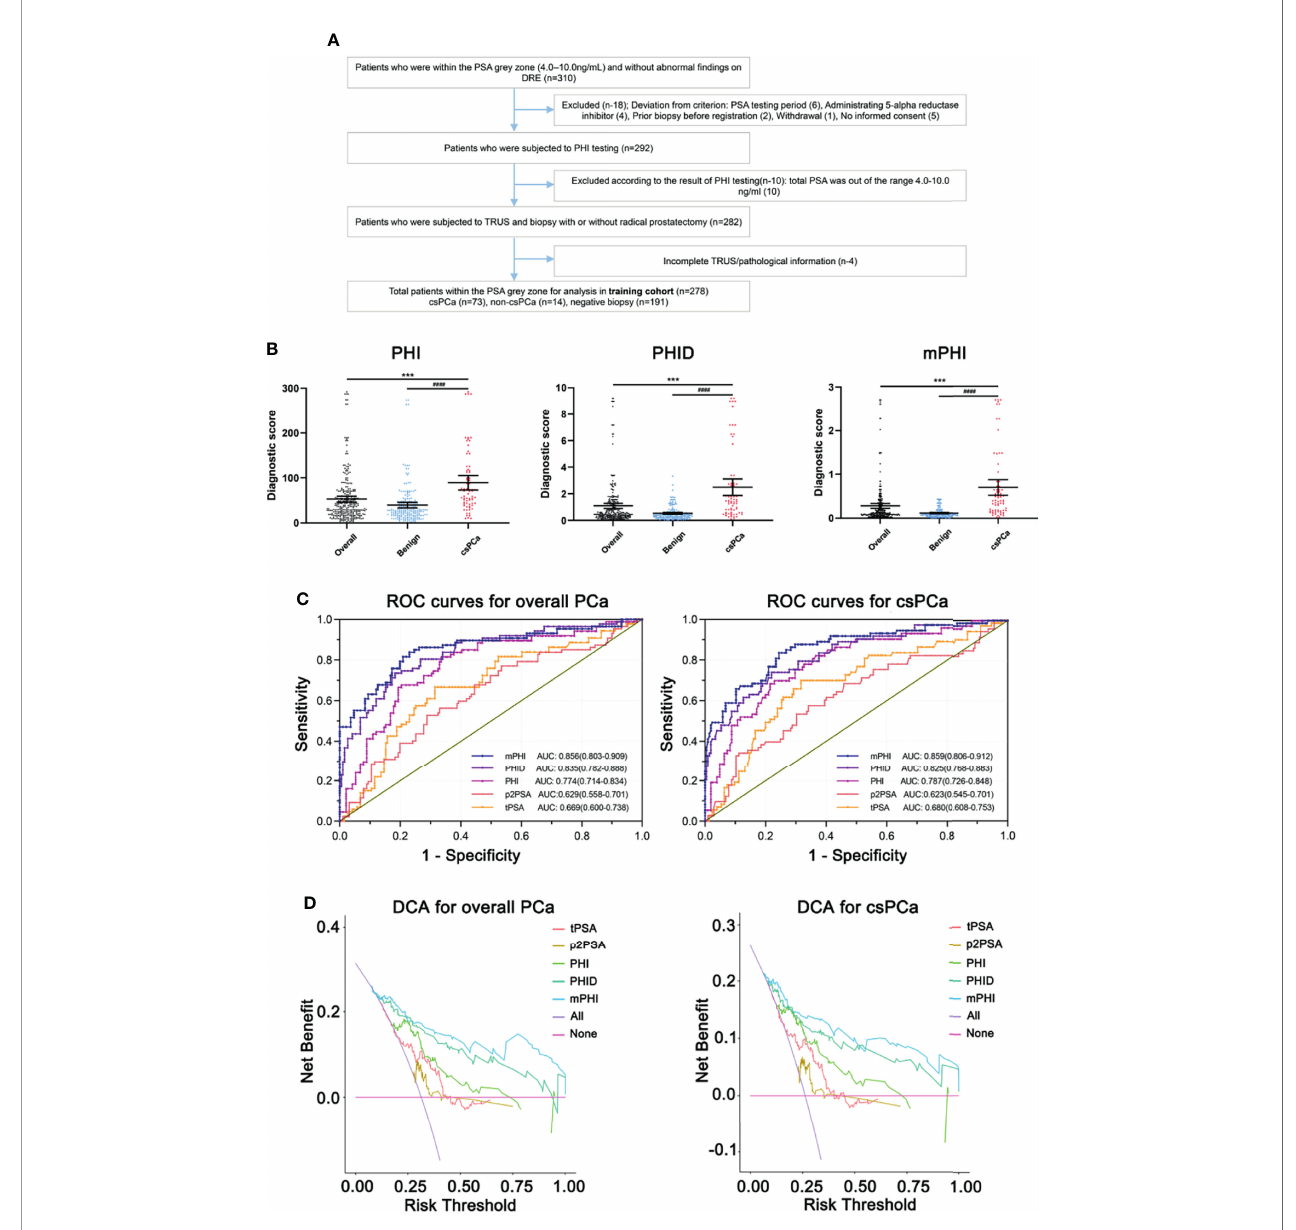
FIGURE 1 | (A) Flow diagram of enrolled participants of the training cohort. (B) Diagnostic scores of PHI, PHID, and mPHI in clinically signi fi cant prostate cancer and benign biopsies identi fi cation. *Overall vs csPCa, # Benign vs csPCa. Data are shown as Mean ± SEM. ***P <0.001, #### P <0.0001. (C) Receiver operating analysis (ROC) curve of the training cohort show the area under the ROC curve for overall PCa (left) and clinically signi fi cant prostate cancer (right) for the prediction of clinically signi fi cant prostate cancer on prostate biopsy, namely, tPSA, total PSA, p2PSA, [ − 2] pro-PSA, PHI, prostate health index, PHID, PHI density, mPHI, (cid:1) PHI). (D) Decision-curve analysis showing the net bene fi t and diagnostic performance of each prediction model in the training cohort for de fi ned as ( LD TRD (cid:1) APD (cid:1) TPV overall PCa (left) and clinically signi fi cant prostate cancer (right). The modi fi ed Prostate Health Index (mPHI) score (top line) demonstrated separation from the other biomarkers across a wide range of threshold values tPSA, total PSA; p2PSA, [ − 2] pro-PSA; PHI, prostate health index; PHID, PHI density; mPHI, modi fi ed and PHID by avoiding unnecessary biopsies of 167 patients at the cost of 11 PCa patients being missed while maintaining 80.8% sensitivity and 76.5% speci fi city in the study cohort. The mPHI outperforms any other predictors, avoids maximum unnecessary biopsies at the least cost of csPC missed% while maintaining the highest diagnostic sensitivity and speci fi city for